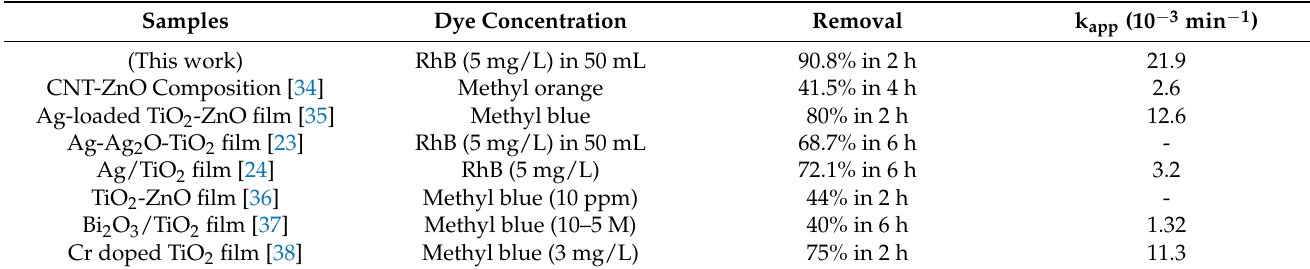
Table 2. Comprehensive comparison of the ZT3 with other recent similar photocatalytic films. Samples